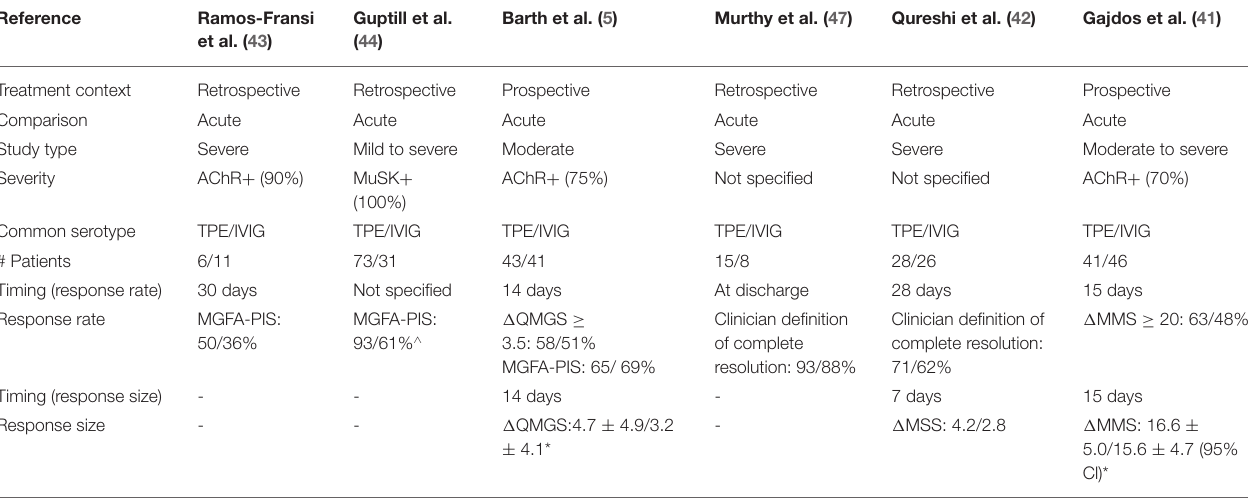
TABLE 4 | TPE vs. IVIG response rates and sizes in acute MG